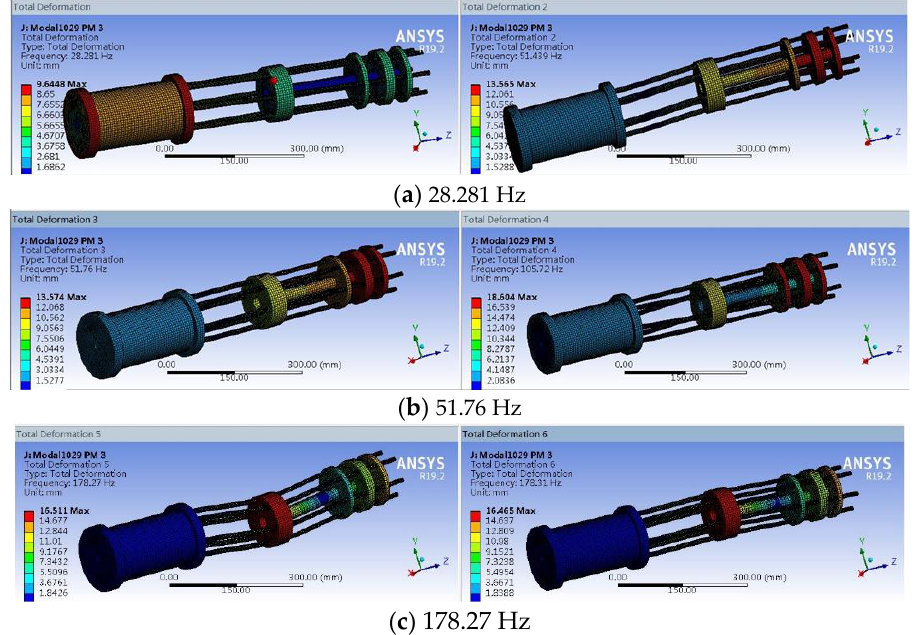
Figure 12. Prestress modal of M134. The M134 shoots at 2000 rpm, as shown in Table 2, which is 34.9 rad/s, and the intermediate state of the third and fourth-order. 34.9 Hz is from the third- frequency (28.281 Hz) to fourth-frequency (51.439 Hz). In addition, with the rpm of 3000, the barrels are neither twisted nor skewed but stretched along the axis of the barrel, which is very beneficial to shooting, with the fourth-frequency of 51.76 Hz, as Figure 12 shows.